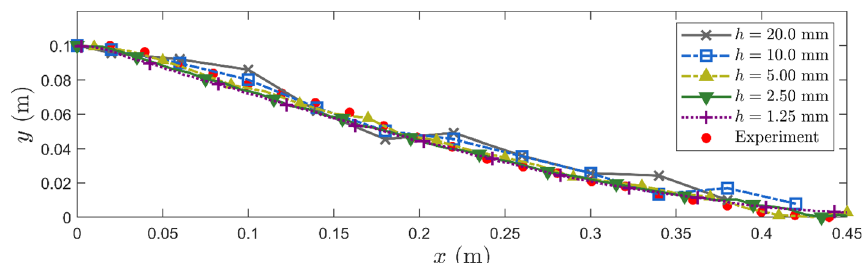
Fig. 16 Surface configurations for various levels of L–SL RK refinement: in the legend, h denotes the initial nodal spacing